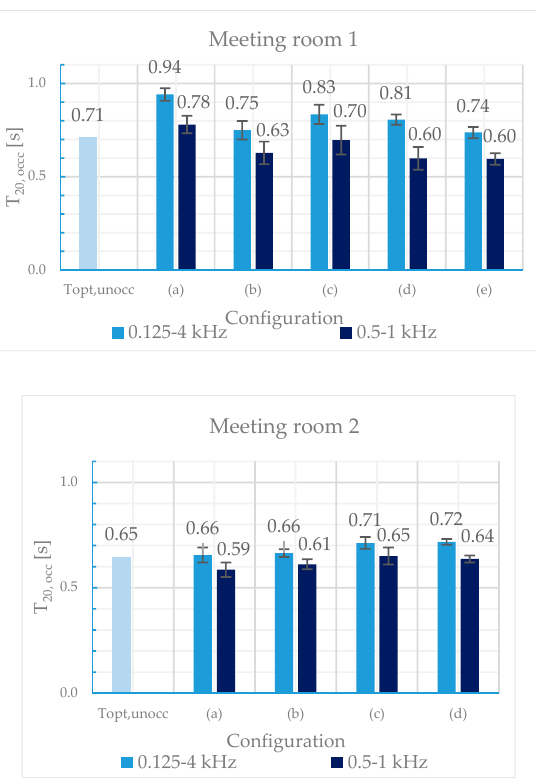
Figure 11. Spatial average values of Reverberation Time T 20,0.125–4 kHz and T 20,0.5–1 kHz in the Mr1 and Mr2 simulated with ODEON 15 for the different configurations in Figures 5 and 6, and optimal Reverberation Time in unoccupied conditions, T opt,unocc . The error bars represent the standard deviation across different measurement positions.